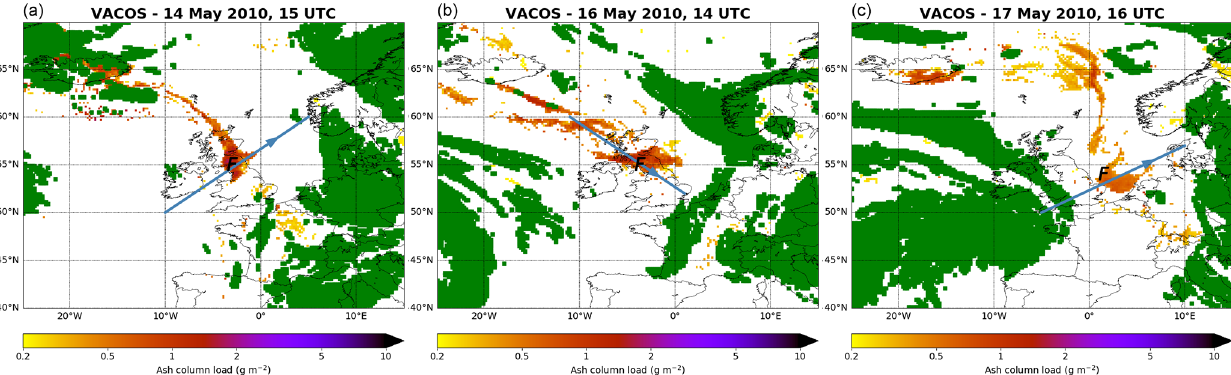
Figure 3. Ash column load retrieved from MSG/SEVIRI by the VACOS algorithm, for different dates (a–c) : 14 May at 15:00UTC, 16 May at 14:00UTC, and 17 May at 16:00UTC. The green zones refer to areas where the ash detection was not possible due to the presence of high clouds. The blue lines are the cross sections shown in Fig. 6, and F indicates the region where the FAAM flights made lidar measurements that are used in the